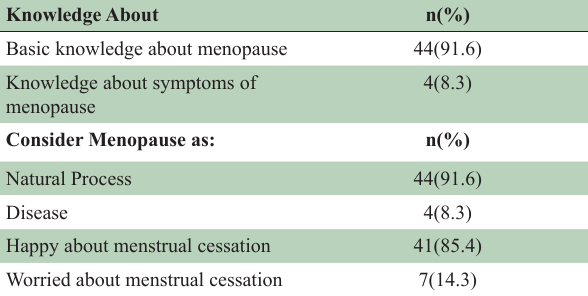
Table-II: Knowledge & Attitude towards